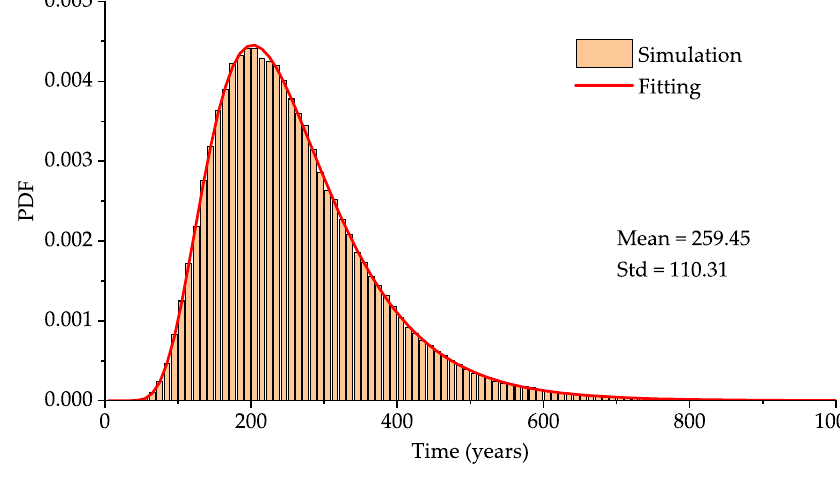
Figure 4. Probability distribution of T i .